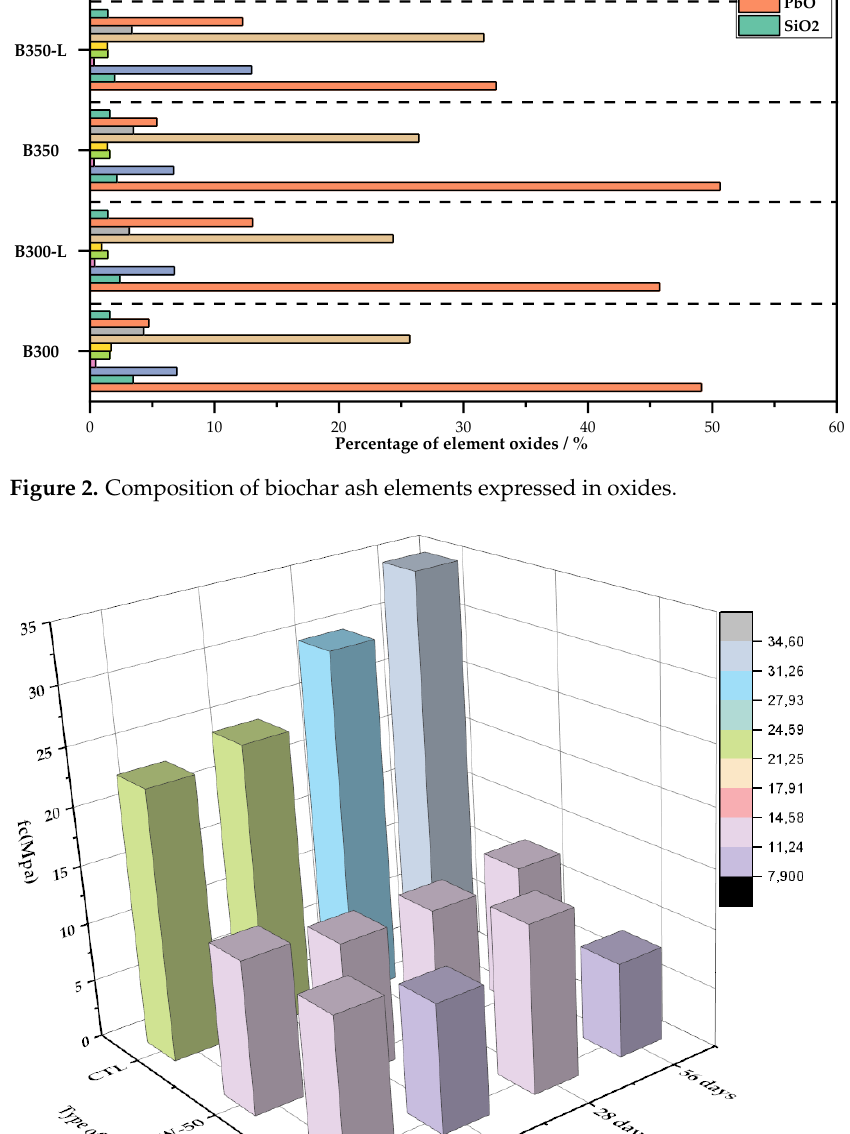
Figure 4. Compression test results for specimens with a partial replacement of cement with biochars produced at temperatures of 300, 350, and 400 °C.